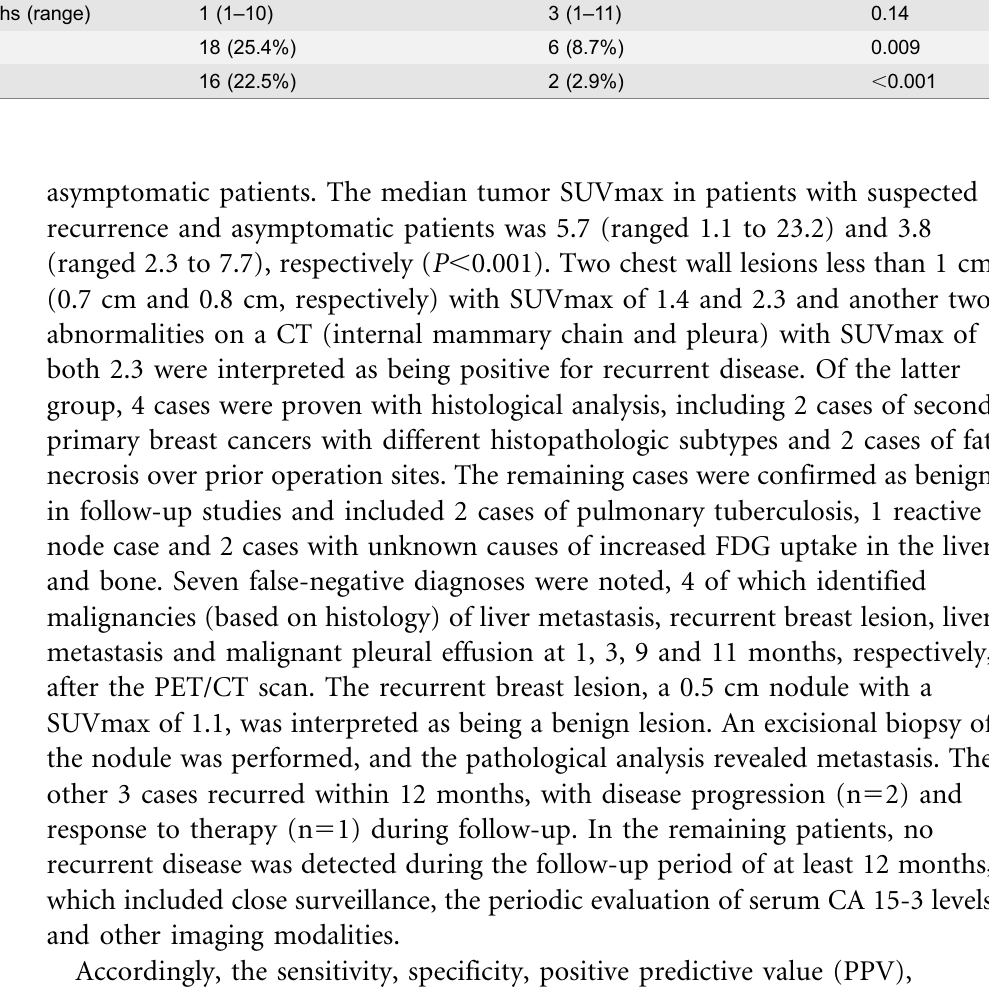
Table 2. The outcome of FDG-PET/CT studies in patients with suspected recurrence and in asymptomatic